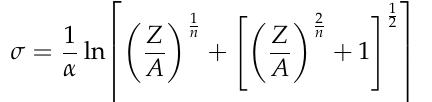
Figure 4. Variation of ( a ) 𝑞 and ( b ) A .